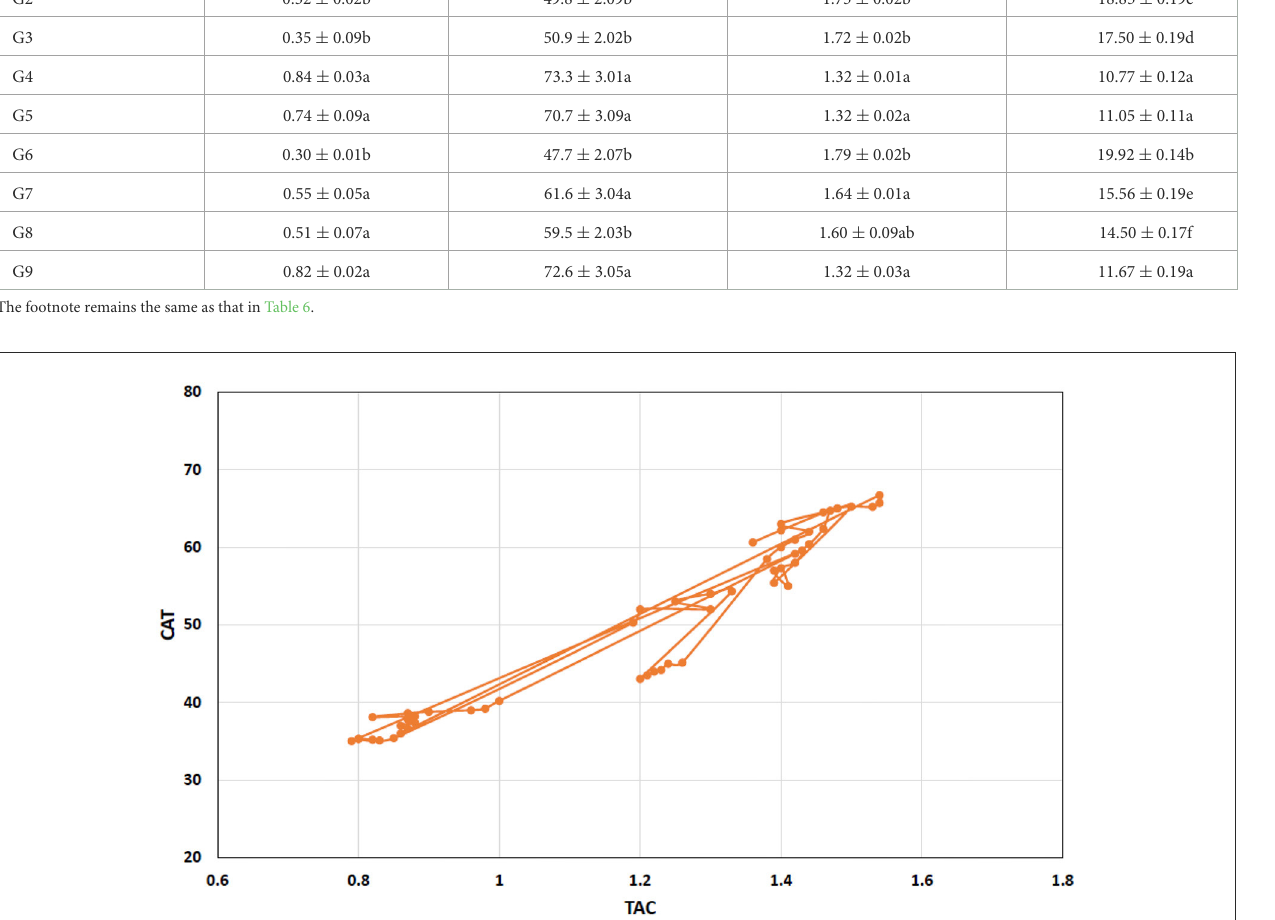
chromium + arsenic (group 6) was observed. The liver of group 1 showed no microscopic lesion, and hepatocytes had a well- preserved lobular